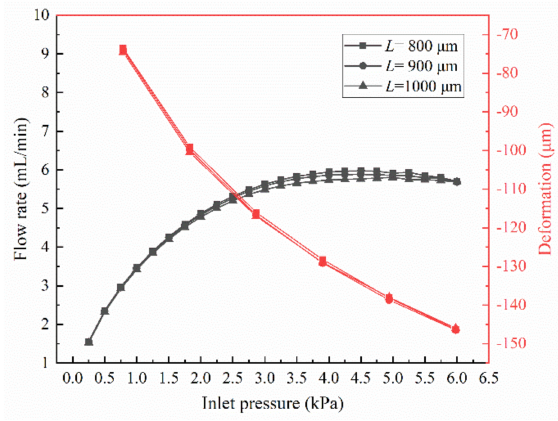
Figure 8. Flow rates and maximum deformation of the MPV with di ff erent pitches of microholes under varied inlet pressures ( n =